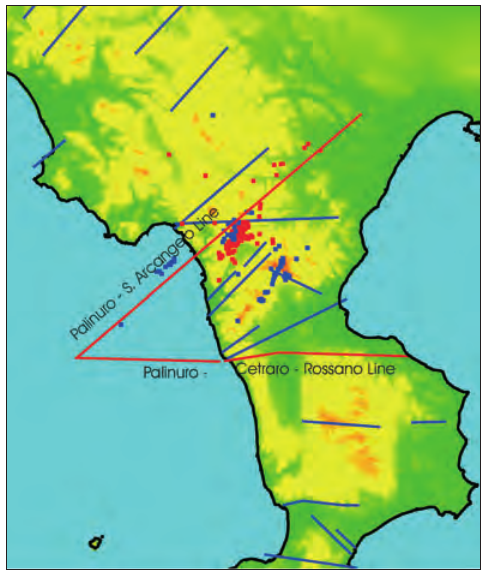
Fig. 15. Scheme of the proposed limit of the hinge between the Southern Apennines and the Calabrian Arc at crustal